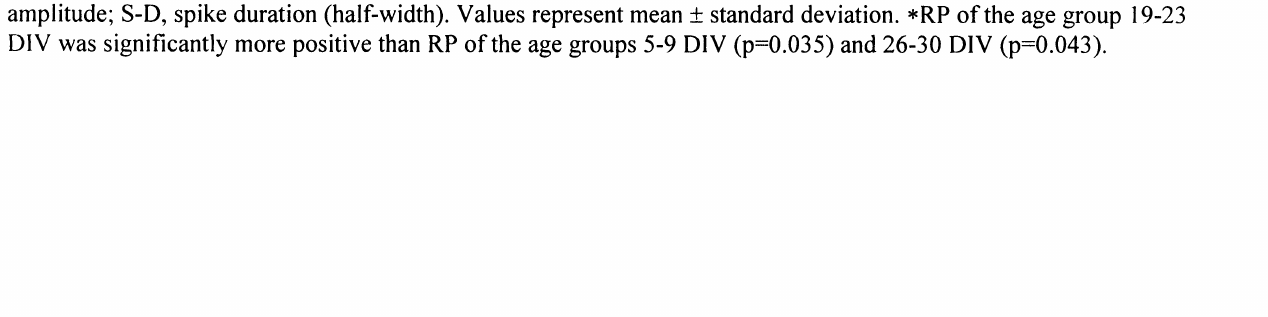
Electrophysiological properties of MNH neurons in culture